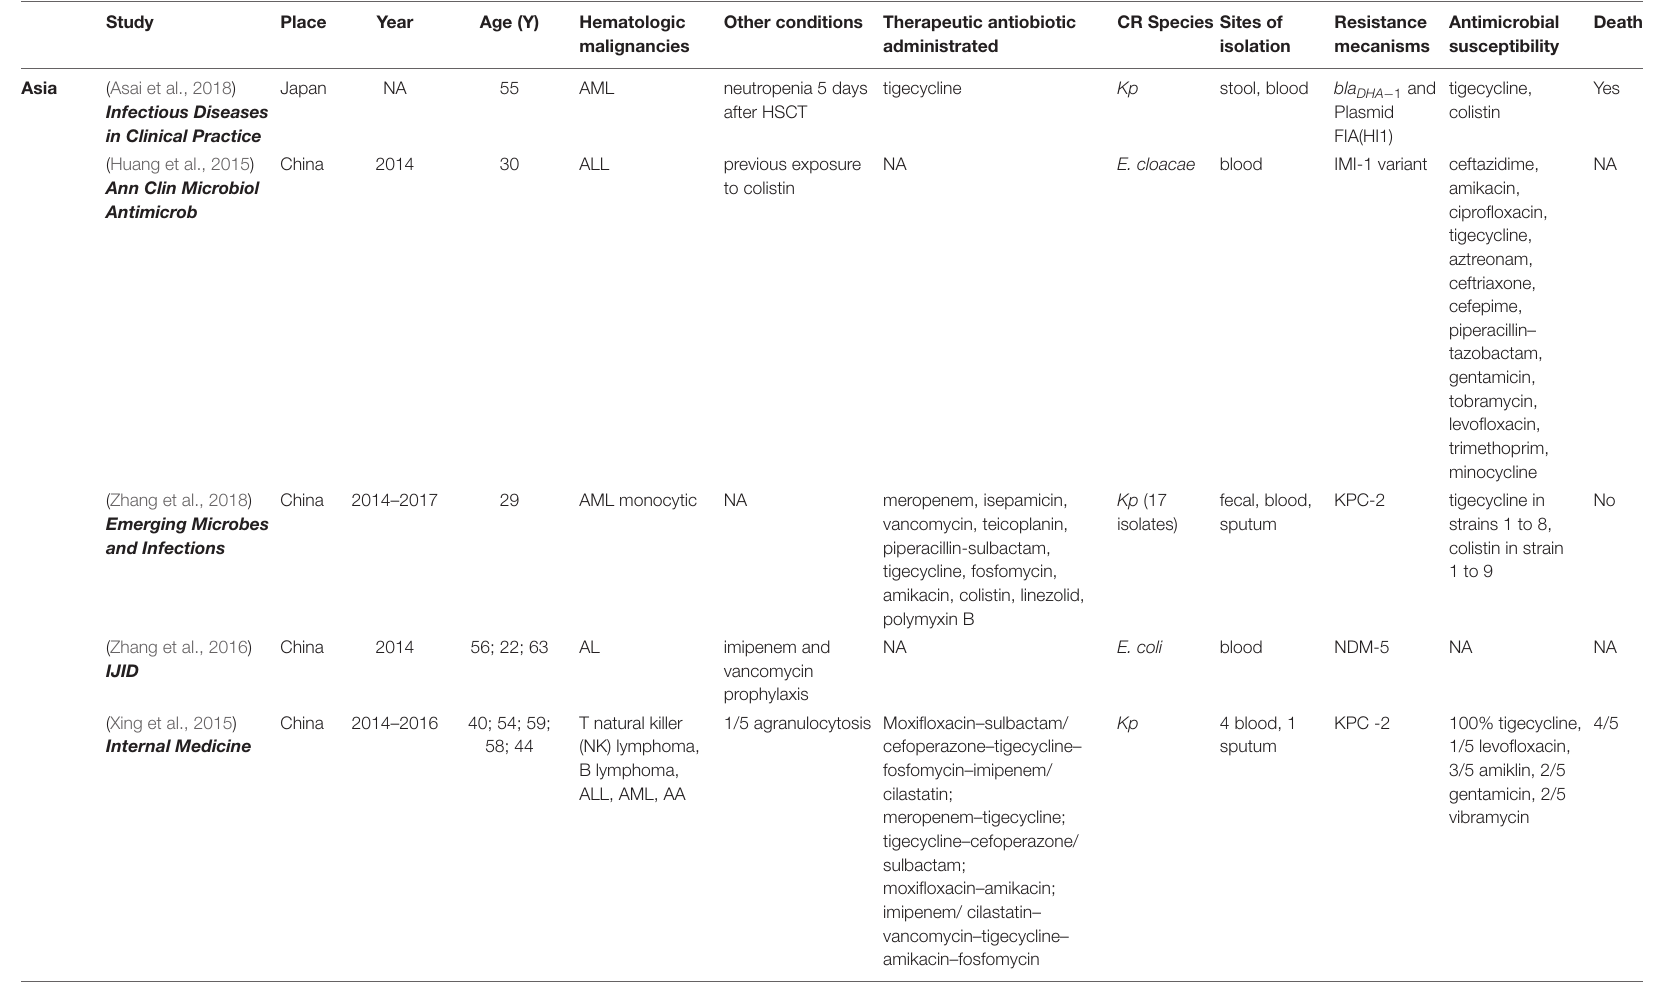
TABLE 4 | Characteristics of case reports studies reporting CR bacteria in HM